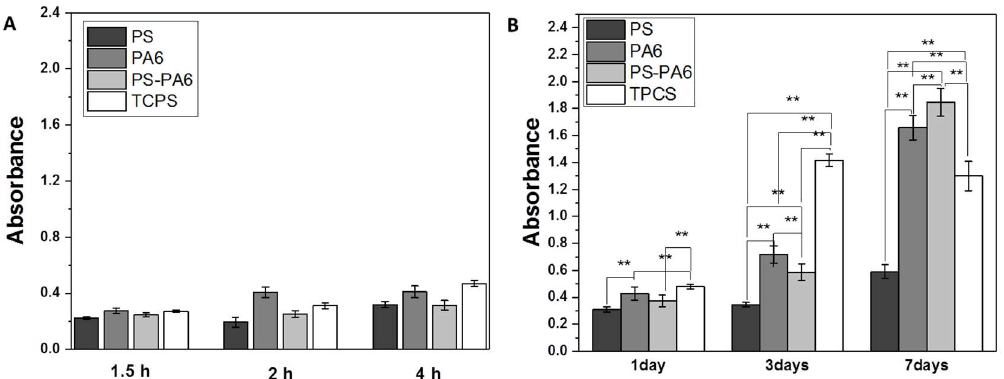
Figure 4. Cell culture study on electrospun PS, PA6 and PS-PA6 composite meshes showing ( A ) the adhesion test: 1.5 h, 2 h, and 4 h and ( B ) proliferation assay after 1, 3 and 7 days after cell